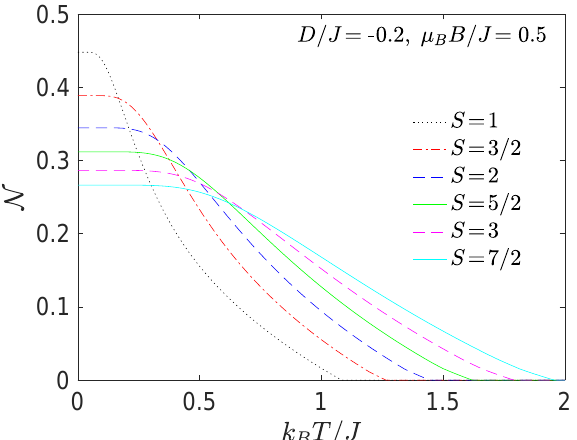
Figure 3. The thermal dependence of the negativity for a few different values of spin magnitudes S calculated at D / J = − 0.2 and µ B B / J = 0.5. The choice of model parameters corresponds to the region where the ground state | ( S − 1/2 ) − (cid:105) is